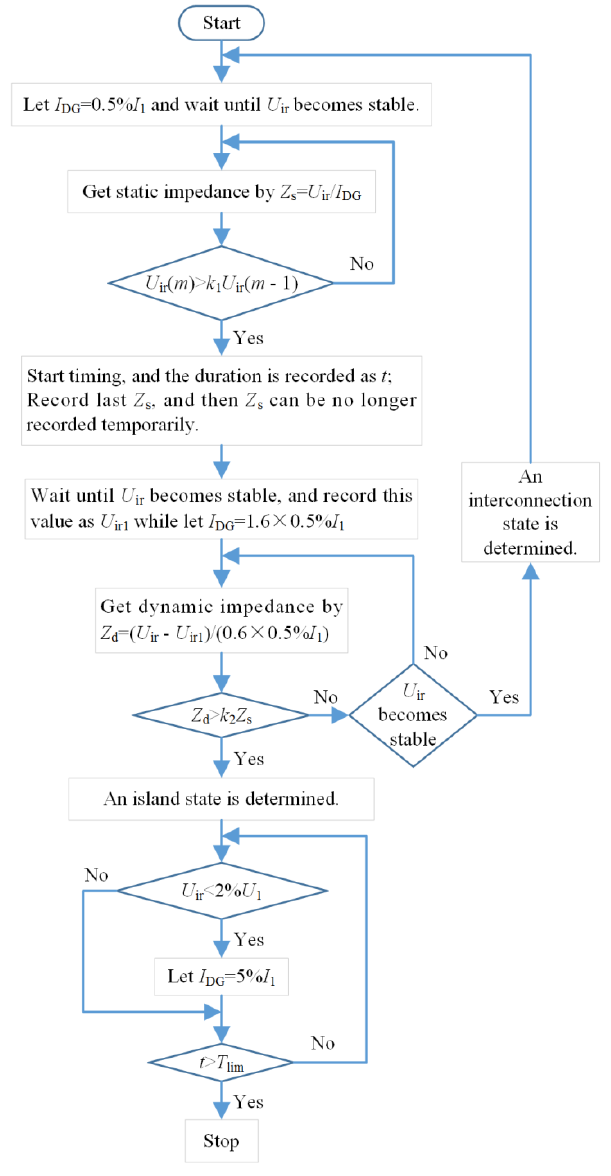
Figure 5. Flow chart of the proposed islanding detection method.